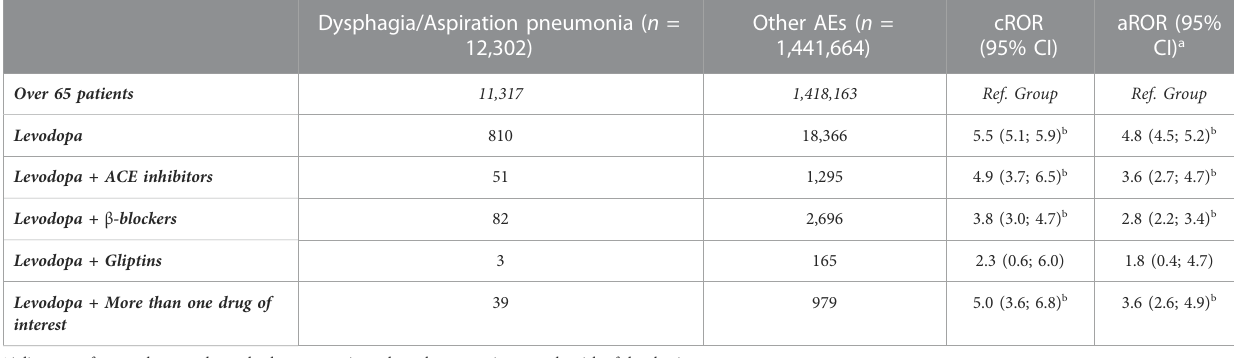
TABLE 6 Univariate and multivariate logistic